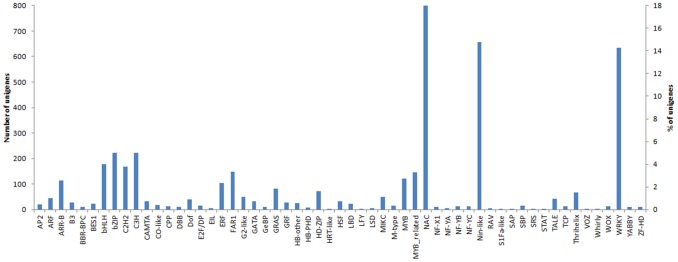
Transcription factor annotations of the unigenes of O. italica obtained from the plant TFDB.